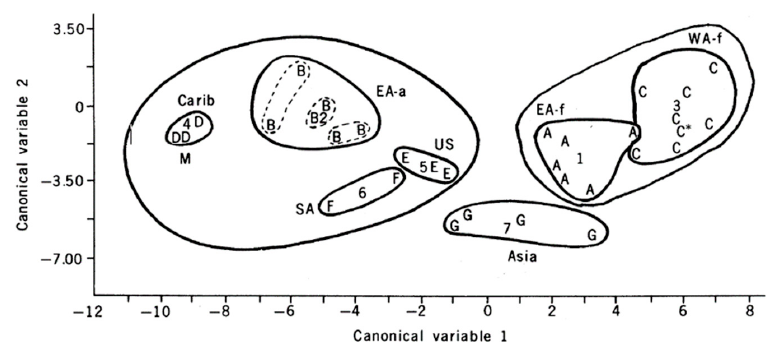
Figure 2. Step-wise linear discriminant analysis based on allozyme variation in populations of Aedes aegypti. Letters indicate population samples, numbers the center of lettered groups. A: East Africa formosus subspecies, B: East Africa aegypti subspecies, C: West Africa formosus, D: Caribbean, E: United States, F: South America, G: Asia. From Reference [19].